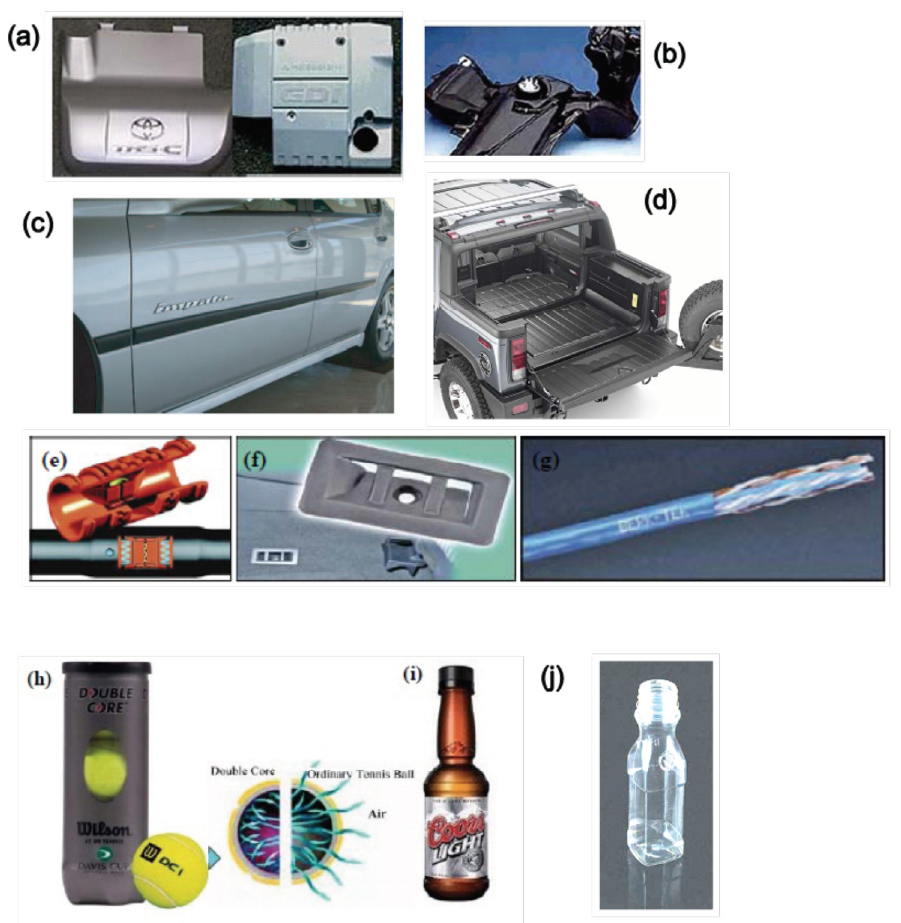
Figure 5. ( a ) Toyota and Mitsubishi engine covers and ( b ) gasoline tank injection-molded from polyamide-6/clay nanocomposites. ( c ) GMC’s Chevrolet Impala 2004: nanocomposite application and ( d ) Polypropylene/EPDM-based nanocomposite: GMC’s 2005 Hummer H2 cargo bed uses ~7